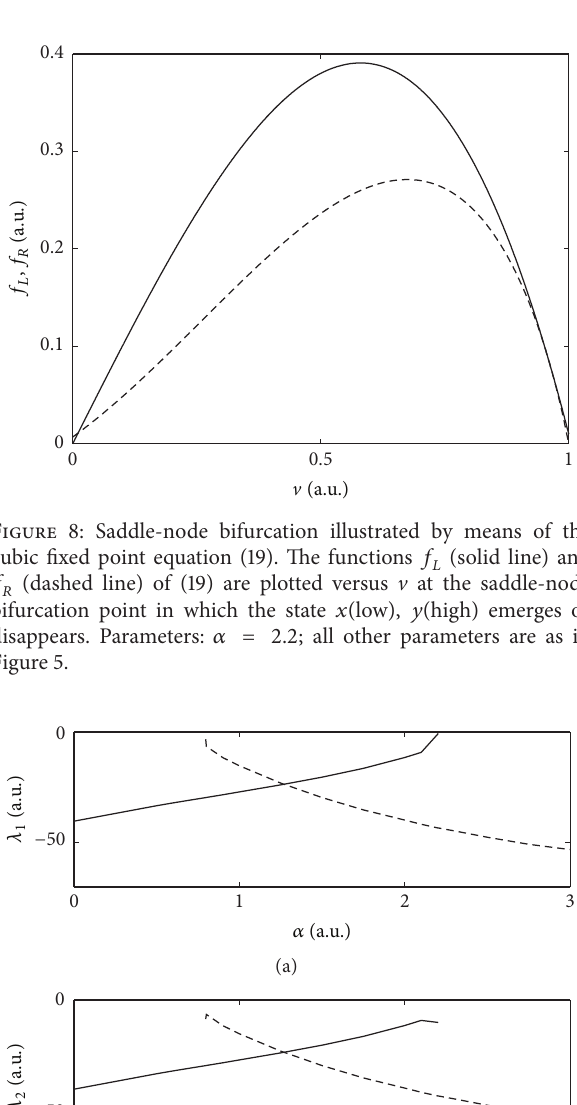
We computed the matrix coefficients for the asymptotically stable fixed points 𝑥 (low), 𝑦 (high) and 𝑥 (high), 𝑦 (low) shown in Figure 5 as functions of the control parameter 𝛼 .